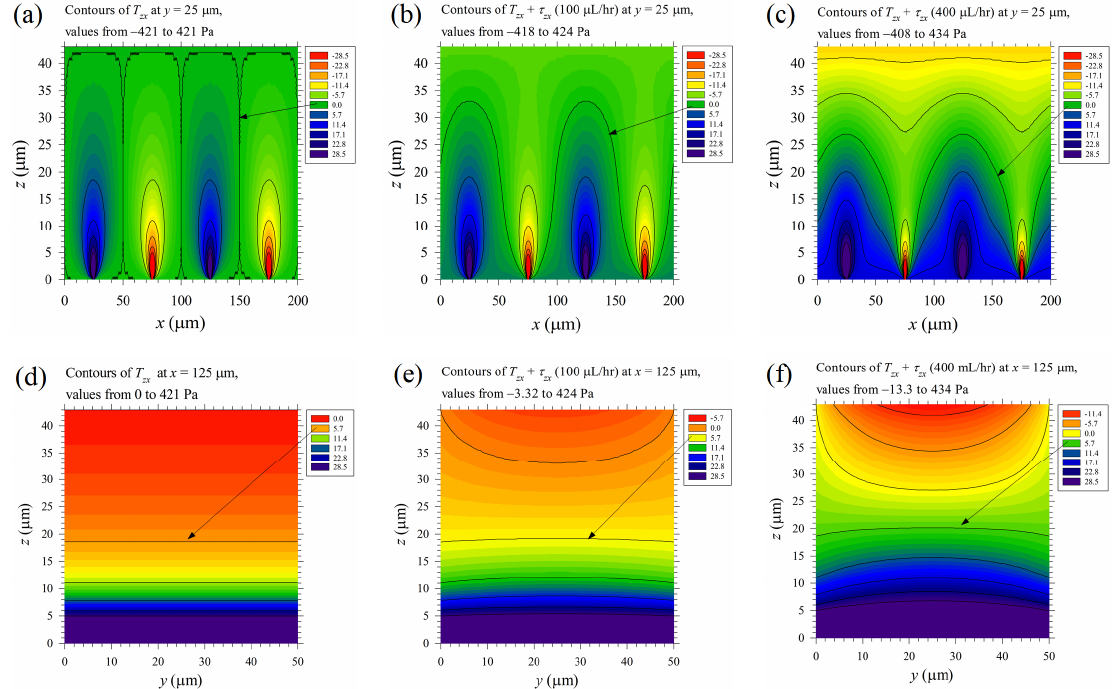
Figure 10. The relative importance between the time-mean Maxwell shear stress component T zx and the mechanical shear stress component, τ zx . ( a – c ) are results on the vertical mid plane at y = 25 µ m, ( d – f ) are results on the vertical cross sectional plane at x = 125 µ m. ( a ) and ( d ) are the pure Maxwell stresses; ( b ) and ( e ) are the total stresses with volume flow rates of 100 µ L / hr, while ( c ) and ( f ) are those at 400 µ L / hr. The applied voltage is 20 V pp . The sign conventions of the contours are similar to those in Figure 7b.